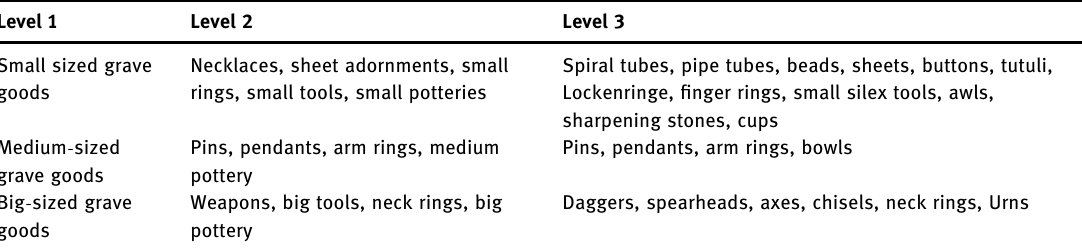
Table 2: Levels of grave goods categories used for WI